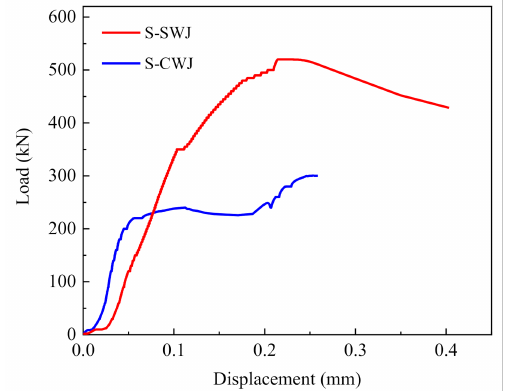
Figure 6. Load–displacement curves of S-SWJ and S-CWJ.